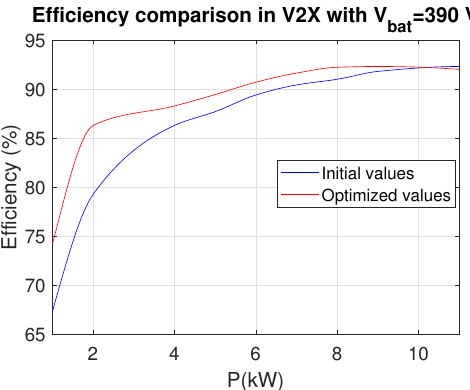
Figure 21. Efficiency comparison in V2X mode with V bat = 390